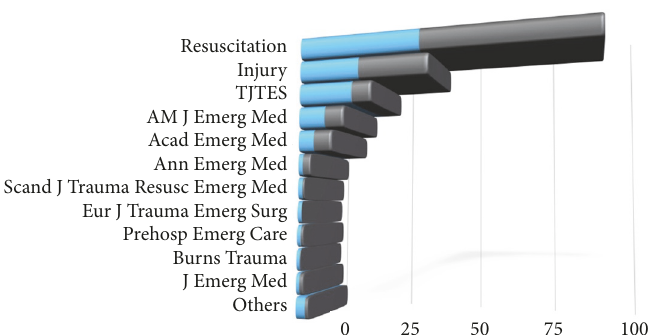
Figure 2: Distribution of the articles and their citation counts according to journals (blue bars: percentage of the articles per journal, grey bars: percentage of the citations per